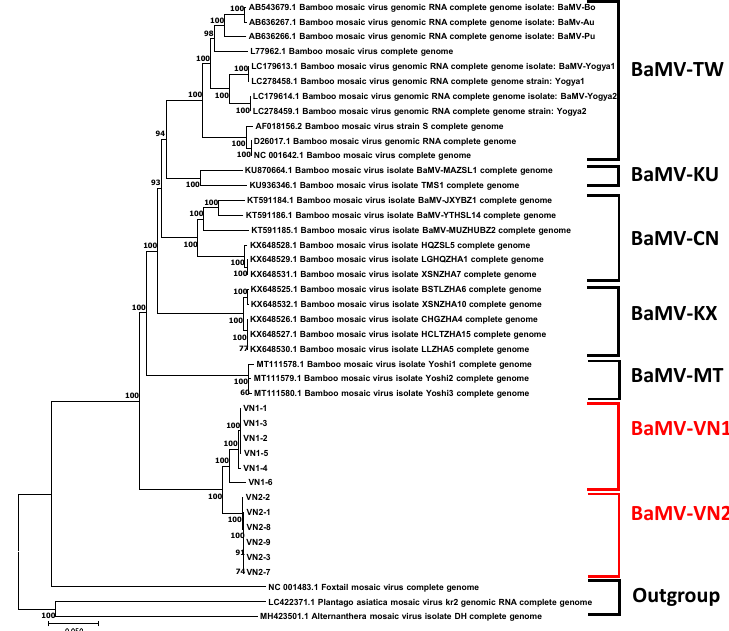
Figure 2. Molecular Phylogenetic analysis of BaMV using the full-length genomic sequences by Maximum Likelihood method. The full-length genome sequences of BaMV strains/isolates, as listed in Table S1, were aligned using CLUSTAL W [31] and subjected to phylogenetic relationship infer- ence using the Maximum Likelihood method based on the Tamura-Nei model [39] in the MEGA X software [30]. The horizontal branch lengths are drawn to scale, relative to the scale bar at the bot- tom, representing 0.05 substitutions per site. The major clades formed by BaMV strains/isolates are indicated on the right, as follows: BaMV-TW, strains/isolates reported in Taiwan and Indonesia; BaMV-CN, strains/isolates from Fujian Province, China, excluding those within the BaMV-KU and BaMV-KX clades; BaMV-KU, strains from Ma bamboo ( Dendrocalamus latiflorus ); BaMV-KX, isolates recently identified in Fujian [6]; BaMV-MT, isolates identified in California, USA; and BaMV-VN1 and -VN2, Vietnam isolates from the two samples identified in this study. Three potexviruses closely related to BaMV were used as the outgroup in the phylogenetic analysis. 3.3. Detection of Unique Satellite RNAs Associated with BaMV-VN1 and BaMV-VN2 To test whether satRNAs were also associated with BaMV-VN1 and BaMV-VN2, 5 ′ - RACE with BaMV satRNA consensus primer (BS-40: BS40: 5 ′ -TCAACTGGTTGGTG- CACGGT-3 ′ ) was performed using total RNAs extracted from the original bamboo leaf samples as the templates, and the resulting amplicons with expected length of 399 base- pairs were sequenced as described above. The result confirmed that satllite RNAs, desig- nated satBaMV-VN1 and SatBaMV-VN2, were indeed associated with BaMV-VN1 and - VN2, respectively. To analyze the full-length satRNA sequences, specific 5 ′ primers, (5 ′ - GCAGGCCTGGAAAACCAACAGAA-ACG-3 ′